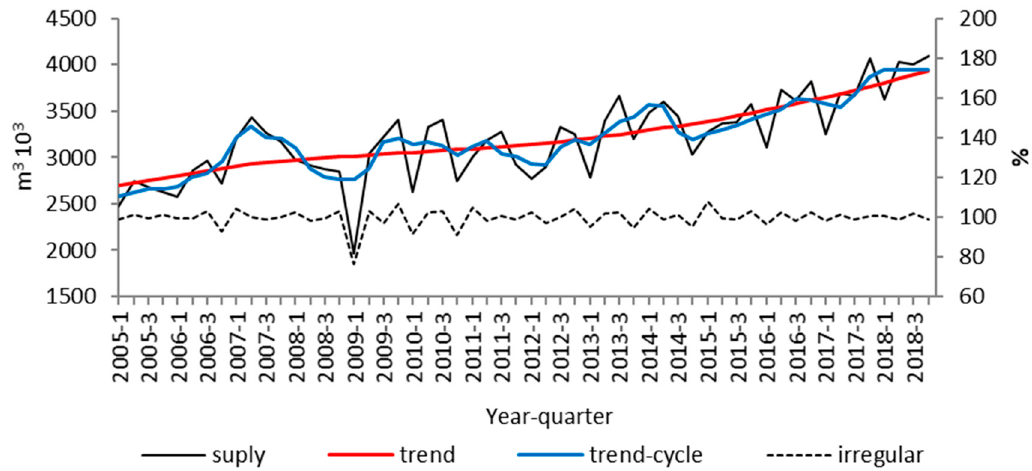
Figure 4. Time series decomposition for large-diameter timber supply (all species together) in Poland in 2005–2018; left axis: cyclical fluctuations and long-term trend; right axis: irregular fluctuations.